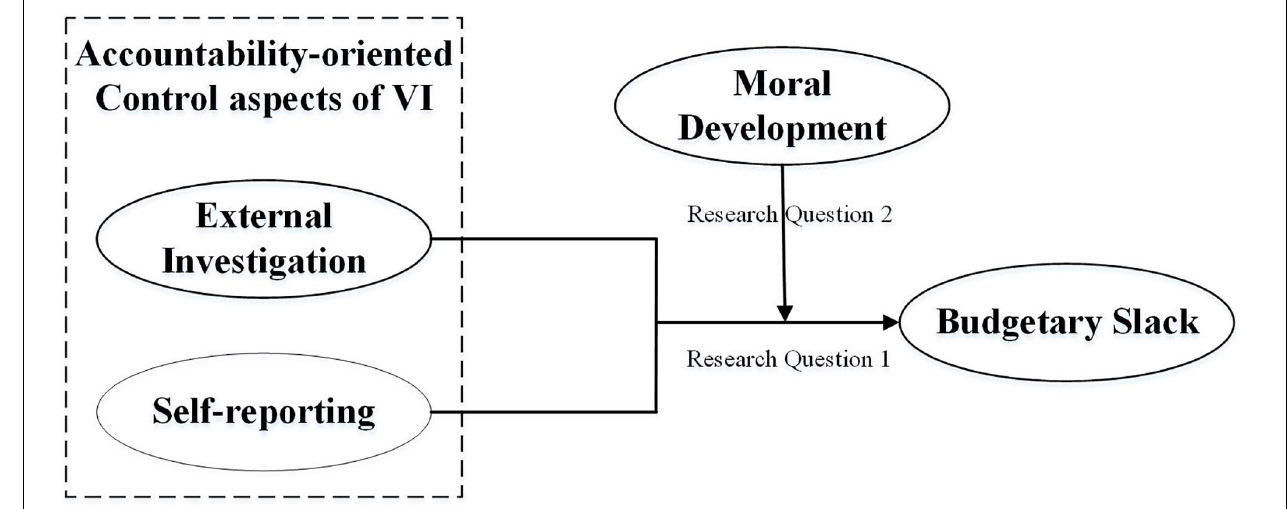
FIGURE 1 | A schematic diagram of this